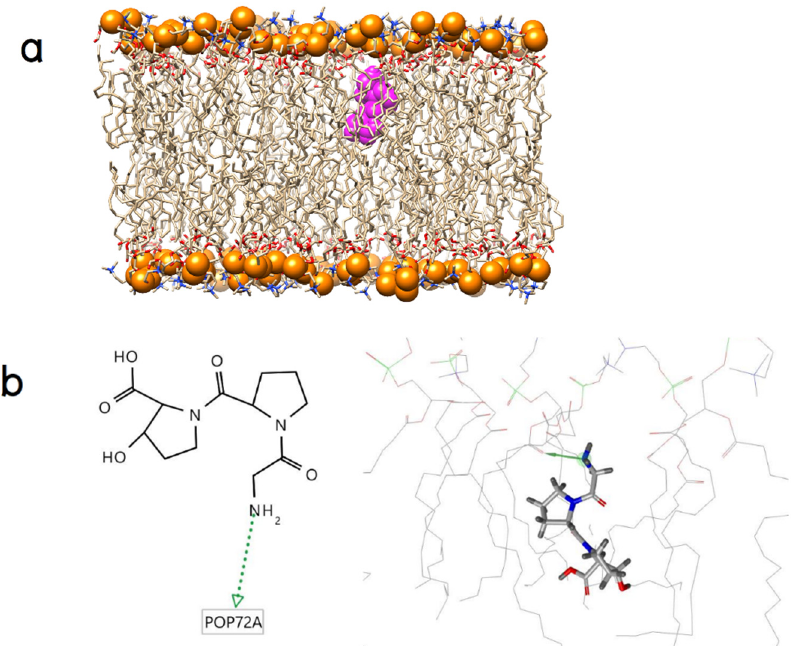
Figure 2. ( a ) An initial position of Gly-Pro-Hyp (magenta surface) and ( b ) Its binding modes (the green arrow represents a hydrogen bond donor).